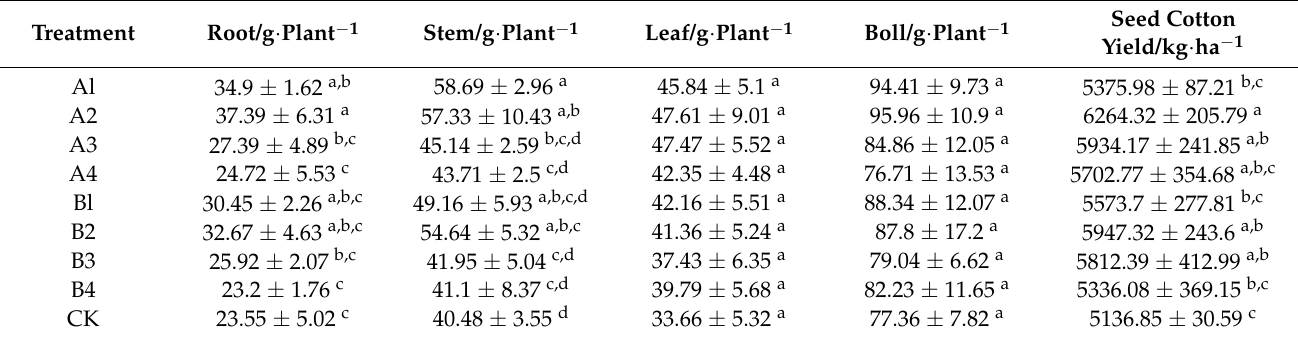
Table 4. Cotton biomass dry weight and seed cotton yield in the boll-opening